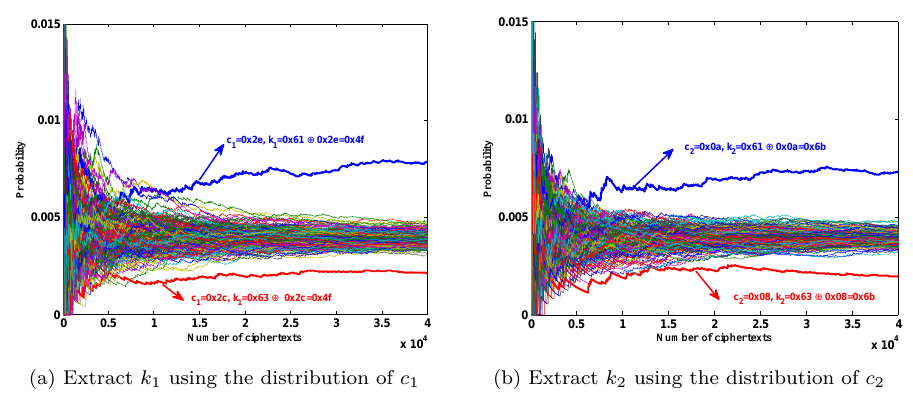
Figure 8: Attack result on AES-128 S-box implementation with